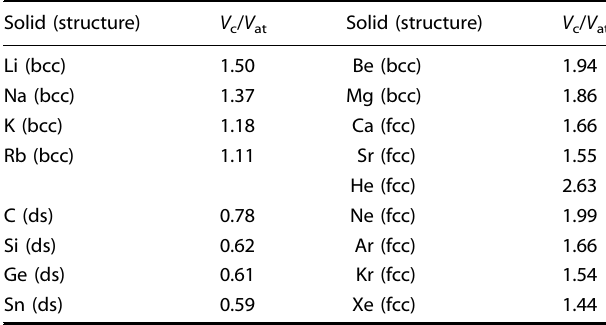
Table 3. Emergent periodic trends.